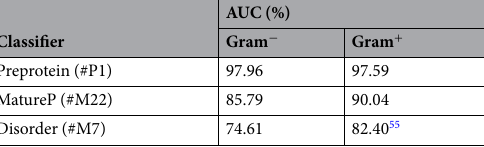
Table 2. Prediction of Gram + and Gram - secretory proteins from their mature domains. We measured the performance of the main classifiers (“preprotein” and “mature domain”) on a set of secretory proteins predicted in other bacterial proteomes. For this analysis we selected 25 Gram - and 10 Gram + bacteria and collected 7120 and 1361 secretory proteins correspondingly (see Methods; Table S5). The E. coli K-12 secretome was excluded since it was used for the initial